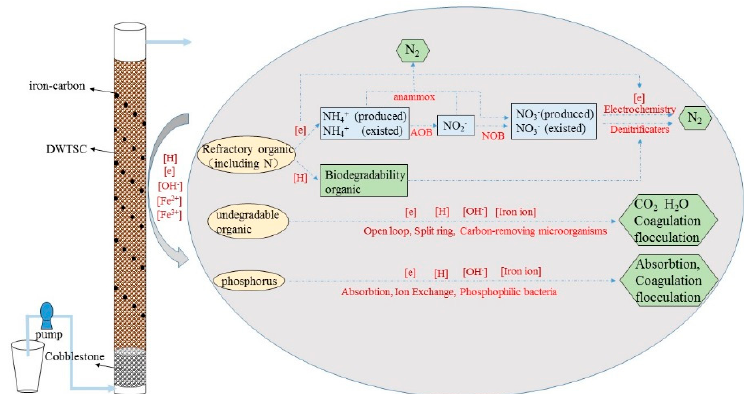
Figure 5. Proposed removal mechanism of organic compounds, nitrogen and phosphorus in the ICWSC-DNBF.